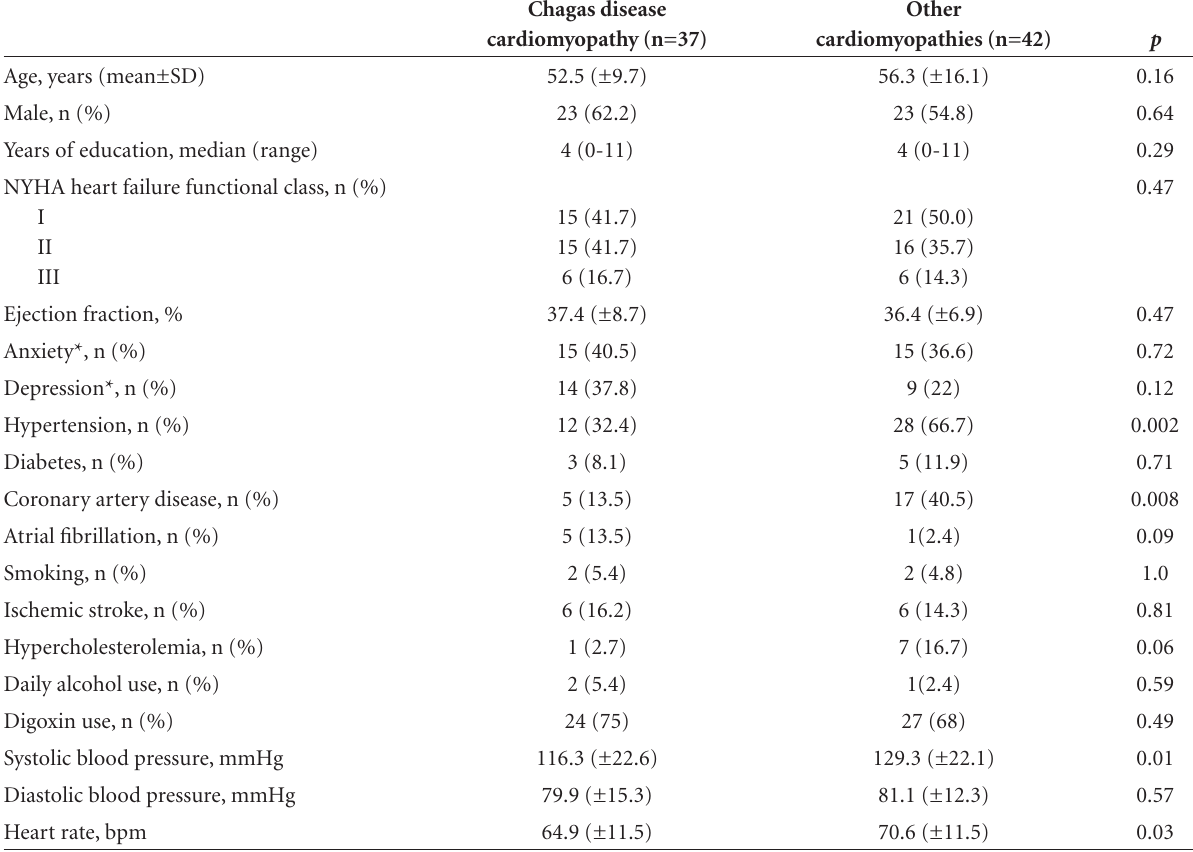
Table 1. Clinical and demographic characteristics of 79 patients with cardiomyopathy.